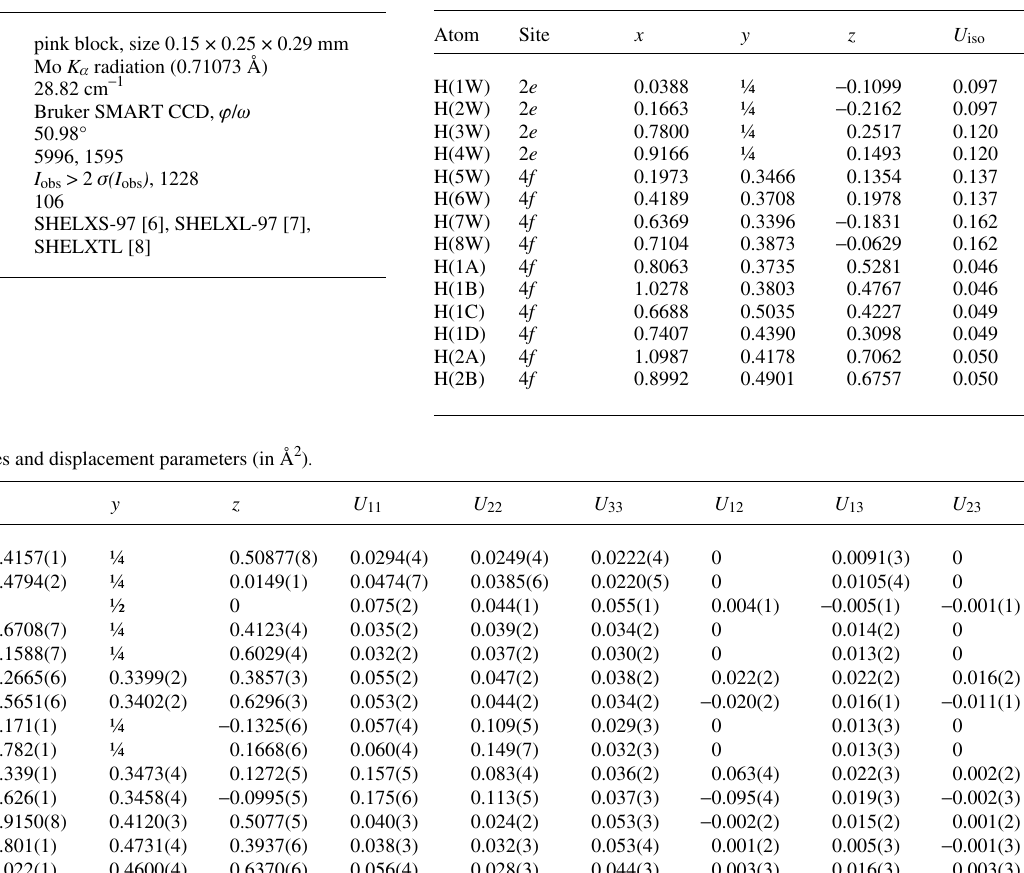
Table 2. Atomic coordinates and displacement parameters (in Å 2 ) . Table 1. Data collection and